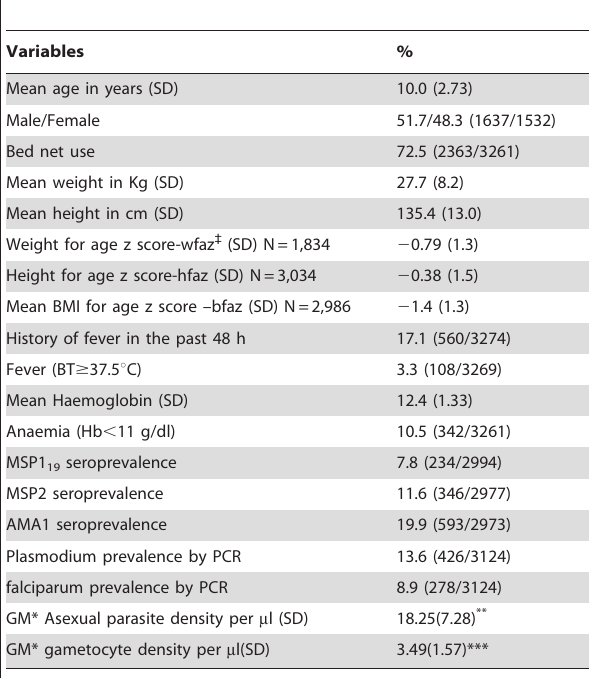
Table 1. Baseline characteristic and prevalence of malaria and